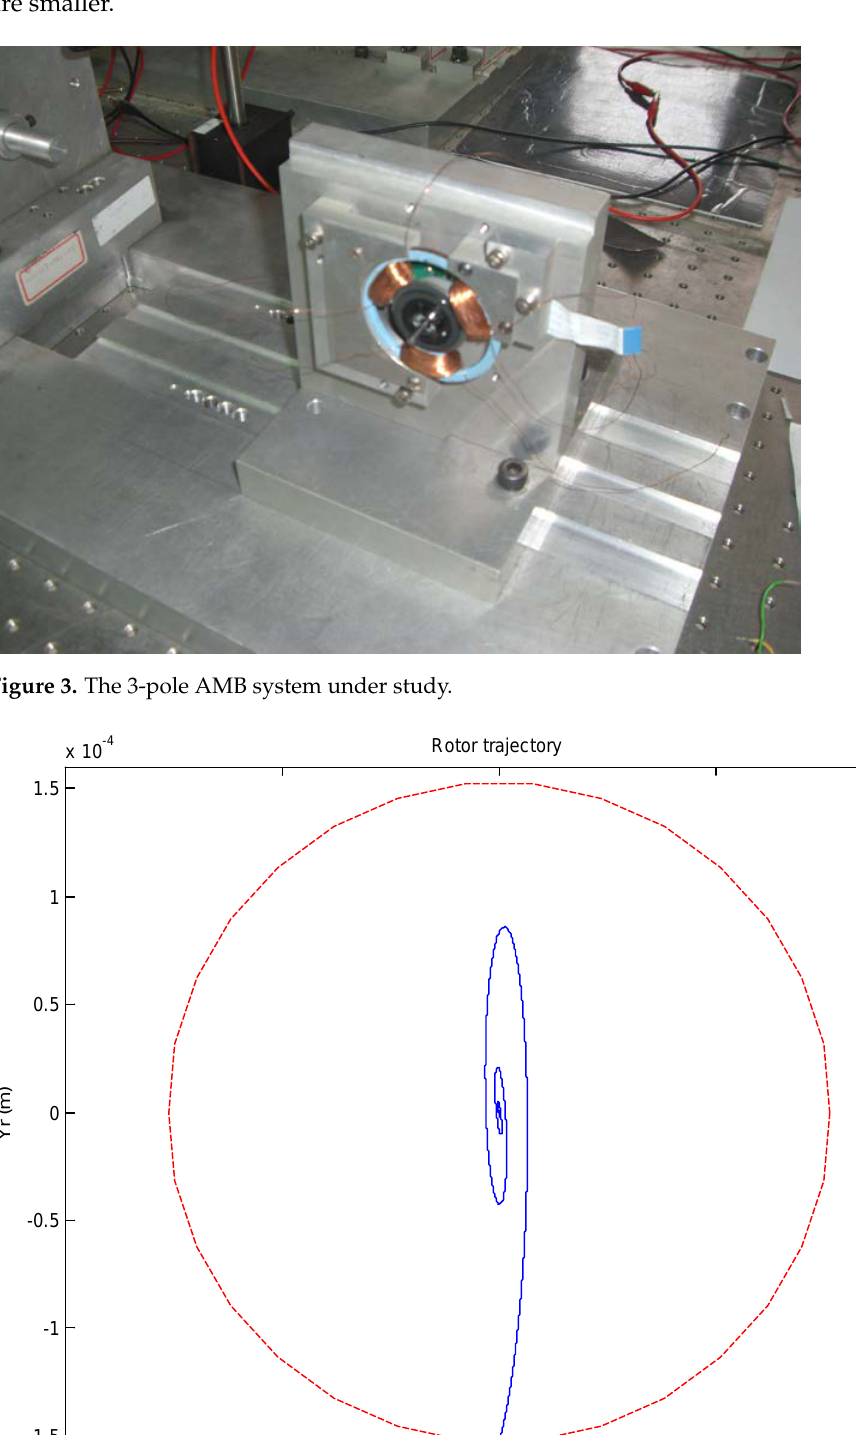
Figure 5. Simulation result: rotor displacement responses. For the experimental results, the rotor trajectory is shown in Figure 6, and the steady- state rotor trajectory is shown in Figure 7. The rotor displacements are shown in Figure 8, and the control currents are shown in Figure 9. It should be note that the rotor is initially at rest on the back-up bearing and the levitation controller is activated at t = 2 s. It is clear that the performance is not as good as the simulation one, with longer settling time and larger steady state error of around 20 um. Recall that it is assumed that the assembly error is 0 1.0 lyx =∆=∆